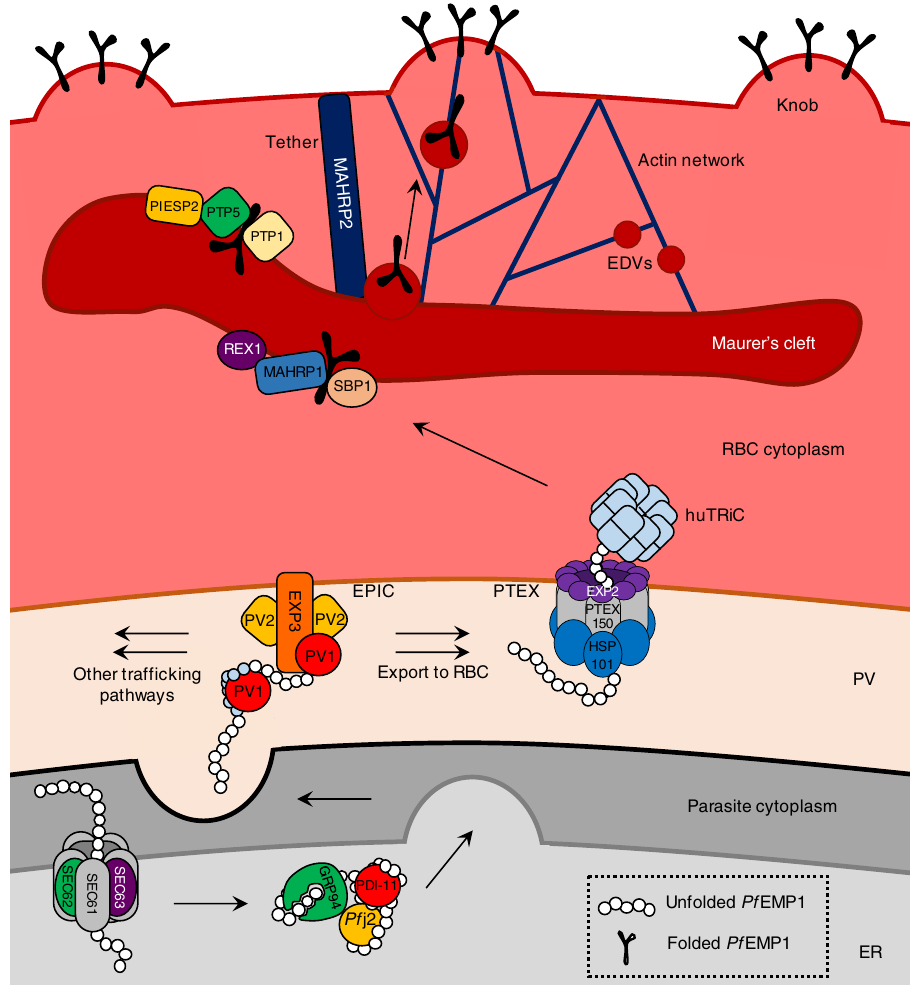
Figure 8 | Model of Pf EMP1 export. Schematic proposed model of Pf EMP1 export mechanisms based on this study. We propose that Pf EMP1 is translocated into the ER via a SEC61-62-63-mediated pathway and traffics through the secretory system with the aid of ER-resident chaperones. Upon secretion into the PV, we propose that Pf EMP1 is recognized by EPIC and transported to PTEX for export to the RBC. EPIC may also be responsible for the targeting of other cargo to alternate trafficking pathways. After crossing the PVM, we propose that Pf EMP1 is received by human TRiC and relayed to the Maurer’s clefts, and that Maurer’s cleft-resident proteins are involved in stabilizing Pf EMP1 at the Maurer’s clefts and targeting it to tethers and/or EDVs for export towards the RBC plasma membrane and insertion into knobs. ER, endoplasmic reticulum; PV, parasitophorous vacuole; EPIC, exported protein- interacting complex; PTEX, Plasmodium translocon of exported proteins; huTRIC, human TCP1 ring complex; RBC, red blood cell; EDV, electron-dense